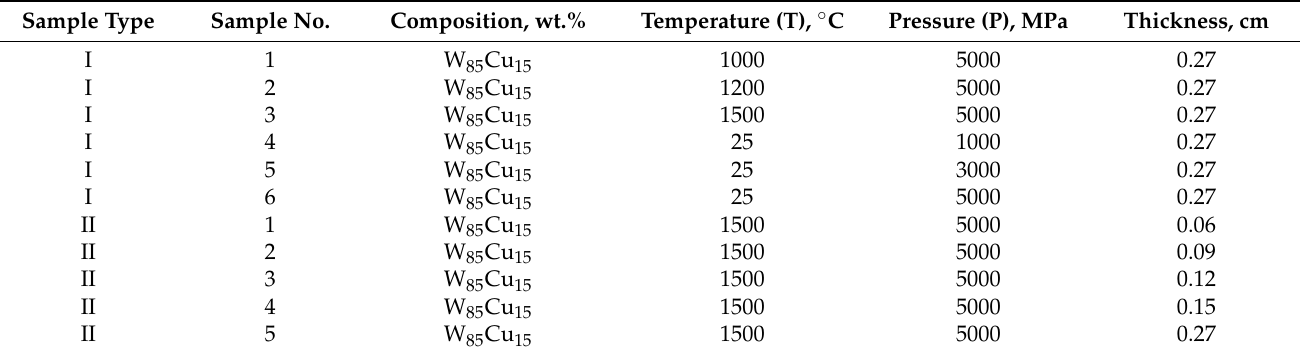
W–Cu composites. Table 1. Sintering regimes of the